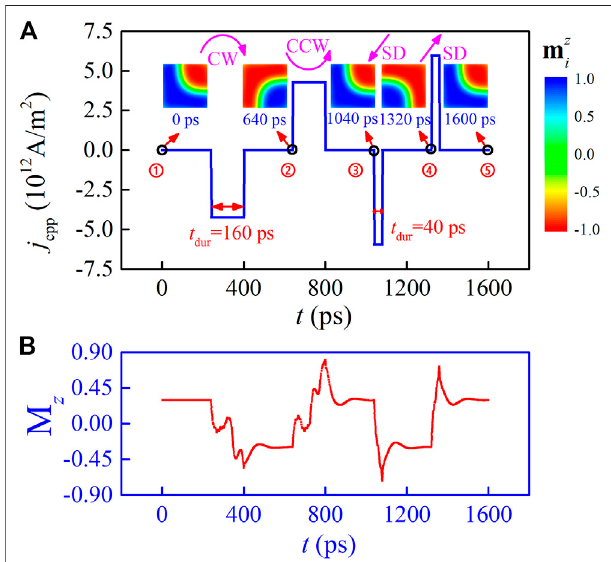
FIGURE 7 | (A) The polarity reversal of kinks induced by CPP pulses, accompanying with the displacements of kinks. The fi rst and second CPP pulseswith j CPP (cid:2) ± 0.05 κ CPP ∼ ± 4.3 × 10 12 Am − 2 and t dur (cid:2) 160psresultinthe rotation of kink along CW and CCW directions respectively, while the third and fourth CPP pulses with j CPP (cid:2) ± 0.07 κ CPP ∼ ± 6.0 × 10 12 Am − 2 and t dur (cid:2) 40ps shifts diagonally (SD) the kink to the diagonal corner of the nanostructure. Snapshots show the kink states ( ① − ⑤ ) at some typical time before and after the pulses in the evolutions. (B) Plots of variations of out-of- plane magnetization M z as a function of time t , responding to the polarity reversal of